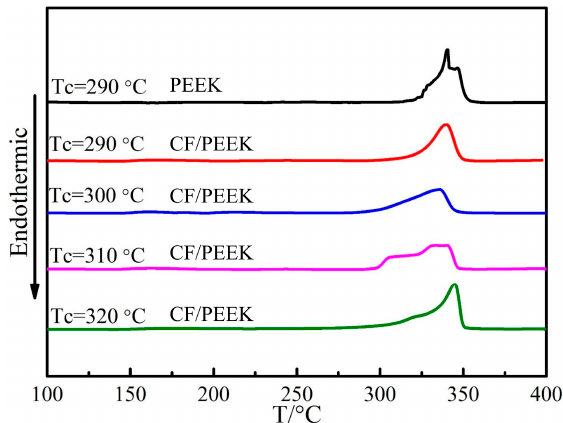
Figure 7. DSC curves of CF/PEEK fabricated at different crystallization temperatures.